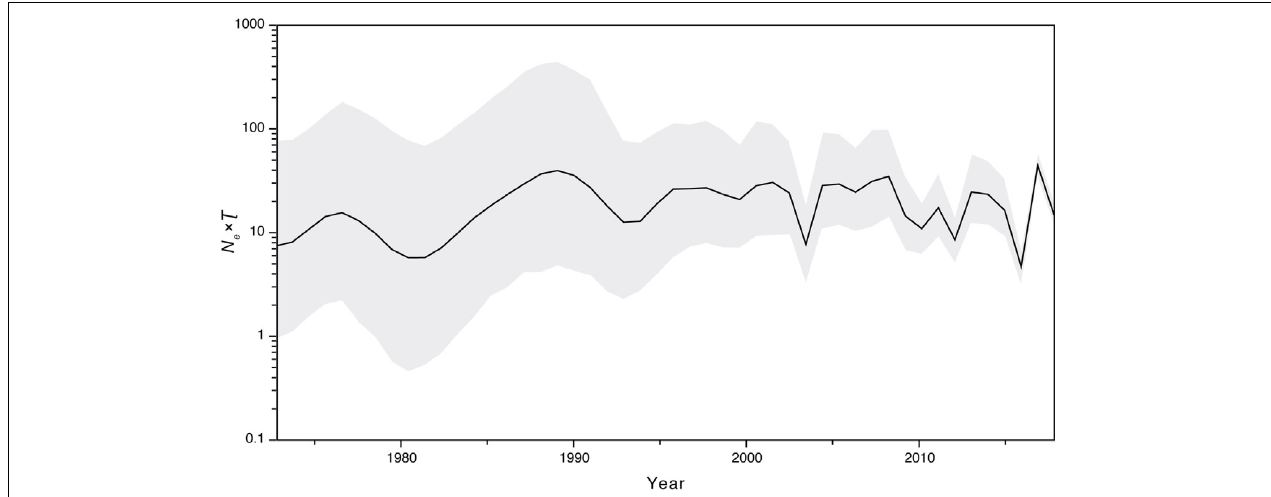
FIGURE 4 | Bayesian skygrid demographic reconstruction of HuNoV GII.2. The vertical axis shows the effective number of infections ( N e ) multiplied by mean viral generation time ( τ ). The solid line and shaded region represent the median and 95% credibility interval, respectively, of the inferred N e τ through time.